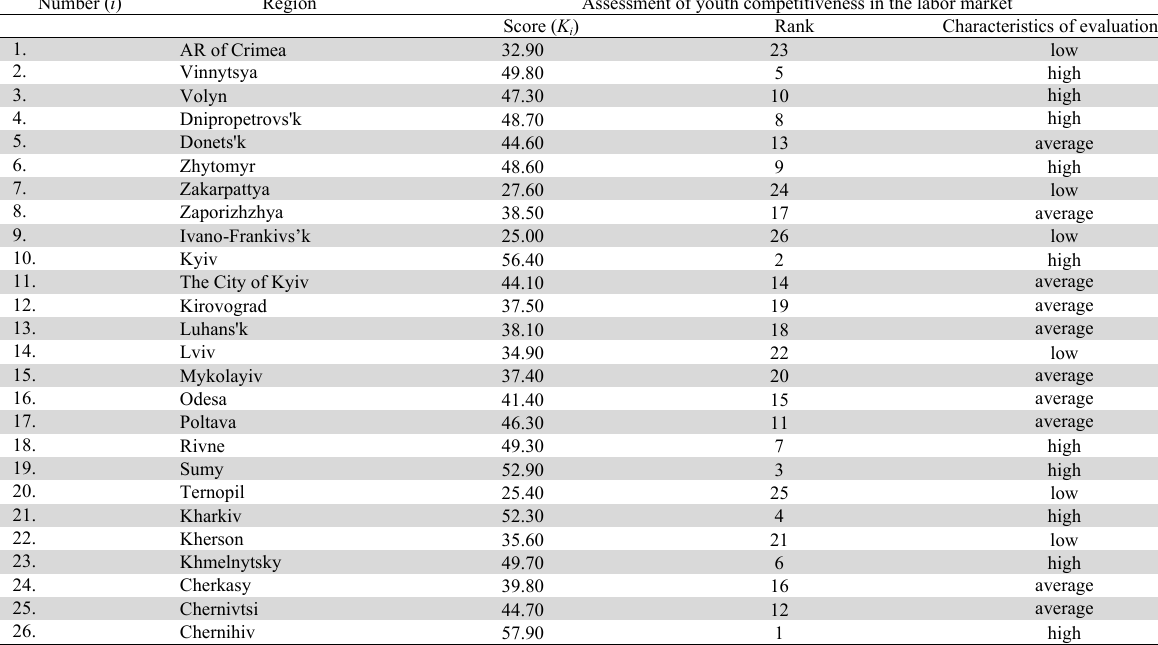
Assessment of youth competitiveness in the labor market by regions of Ukraine Number ( і ) Region